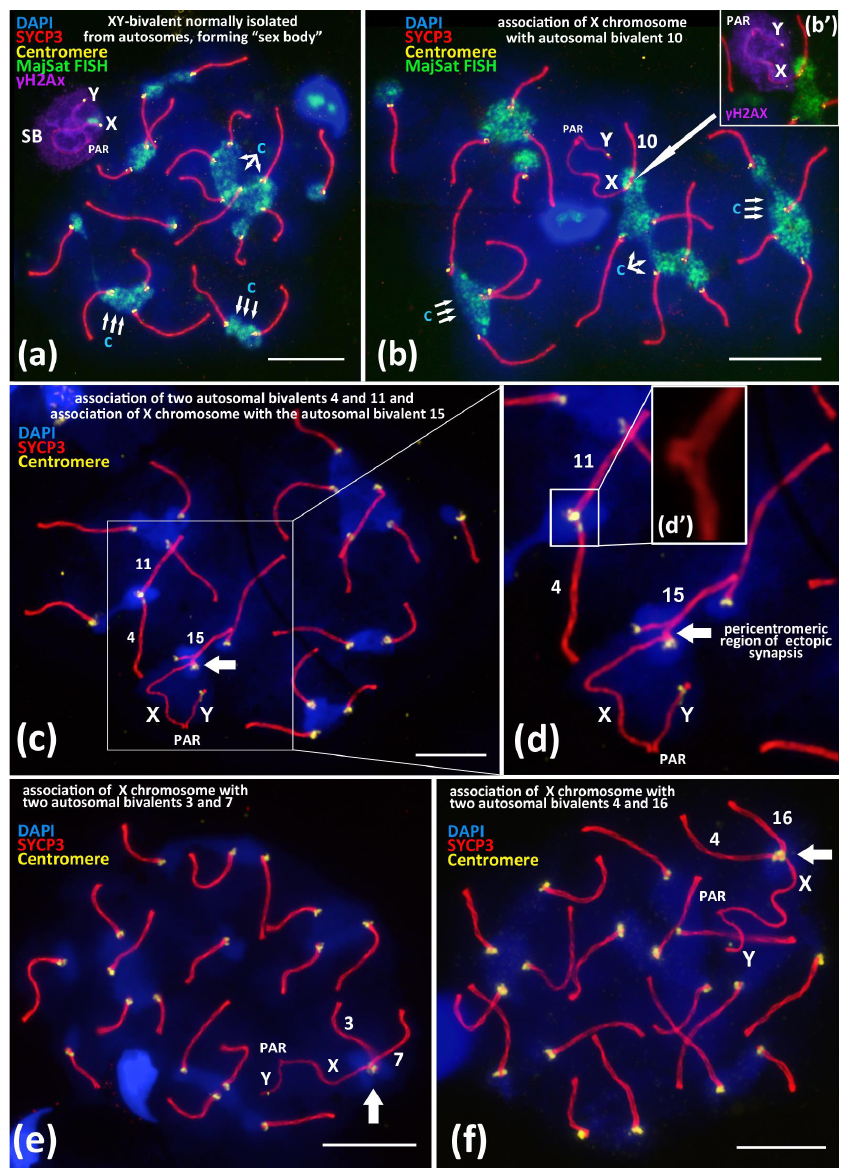
F1 Figure 1. Associations between centromeric regions of autosomal chromosomes and the X chromo- some in BALB/c mouse meiotic nuclei. Chromatin was stained with DAPI (blue), axial elements of meiotic chromosomes were immunostained with the antibodies against the SYCP3 protein (red), centromeres were stained with the ACA antibodies (yellow), and inactivated chromatin of asynaptic sex bivalent was immunostained with the antibodies against γ H2AX (violet). FISH with oligo-DNA probes to MajSat DNA (green). Pseudoautosomal region of the sex bivalent is indicated as “PAR”; chromocenters are indicated “c”. Scale bar—10 µ m. ( a )—Normal meiotic behavior of XY bivalent forming dense DNA-protein structure “sex body” (SB) that is spatially isolated from autosomes in pachytene. Sex bivalent is “covered” by γ H2AX immunostaining (violet), indicating chro- matin inactivation. ( b )—Association between the X chromosome and autosomal bivalent 10 (white arrow). MajSat DNA of X chromosome is included in the chromocenter (green) formed by several autosomal bivalents. ( b’ )—Immunostaining of sex bivalent with anti- γ H2AX